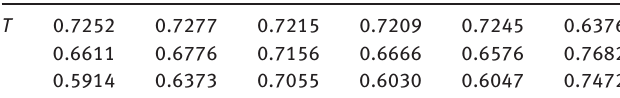
Table 9: The Weighted Supports T .